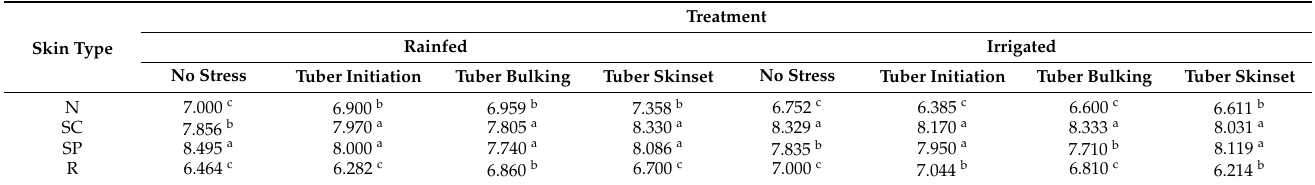
Table 2. Pairwise comparisons of suberized cell layer using Tukey’s method among four skin types, including normal skin (N), surface cracking (SC), silver patch (SP), and russeting (R) in samples of 3 years.